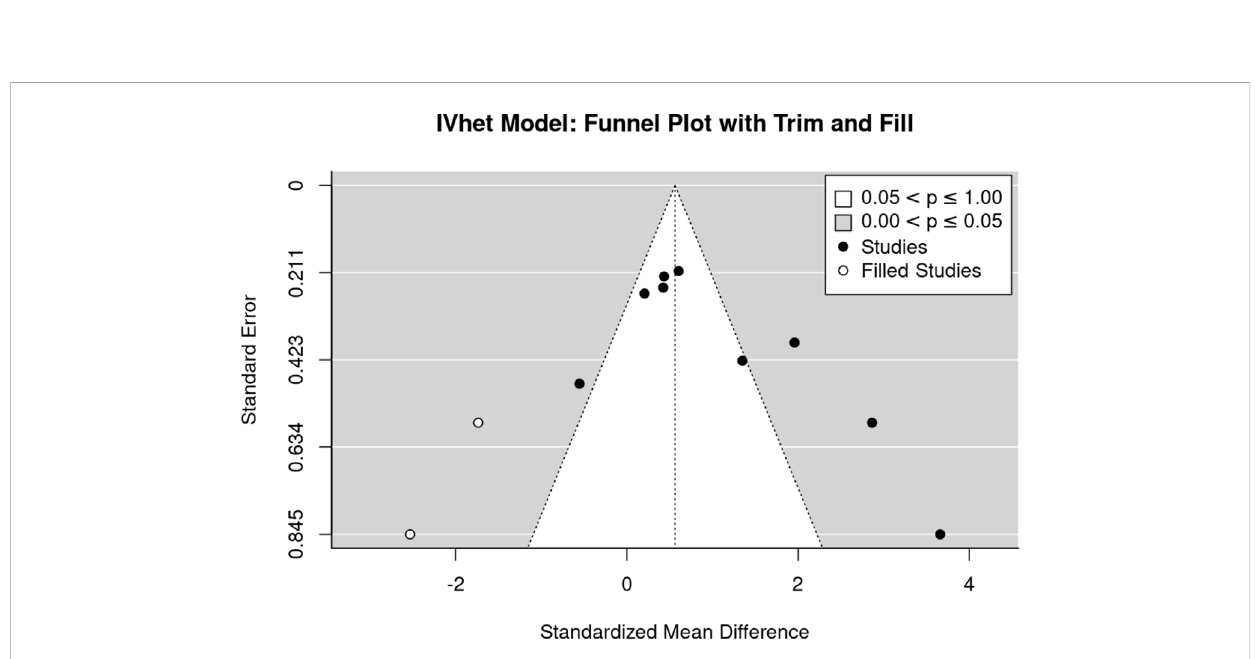
Forest plot of meta-analysis results for the proximal femur region of interest. Data shown as pooled standardized mean difference (SMD) with 95%- CI for changes in the EG versus the